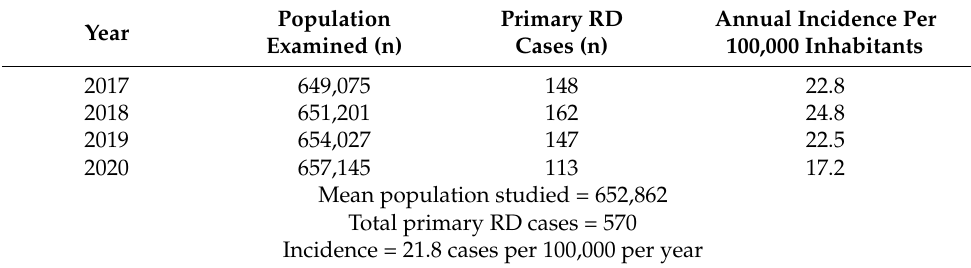
Table 1. Annual incidence and 4-year mean incidence.